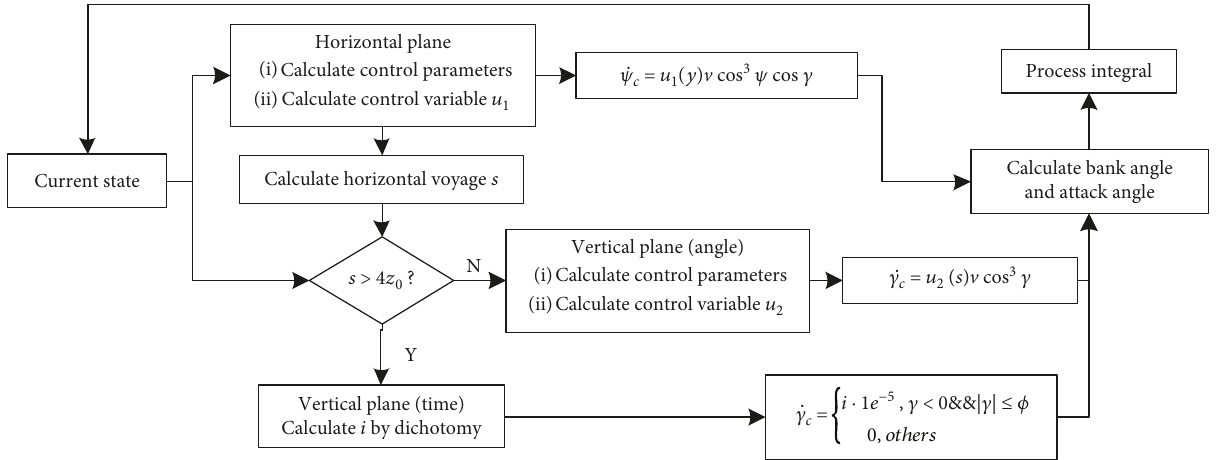
Figure 4: Terminal guidance process based on real-time parameter